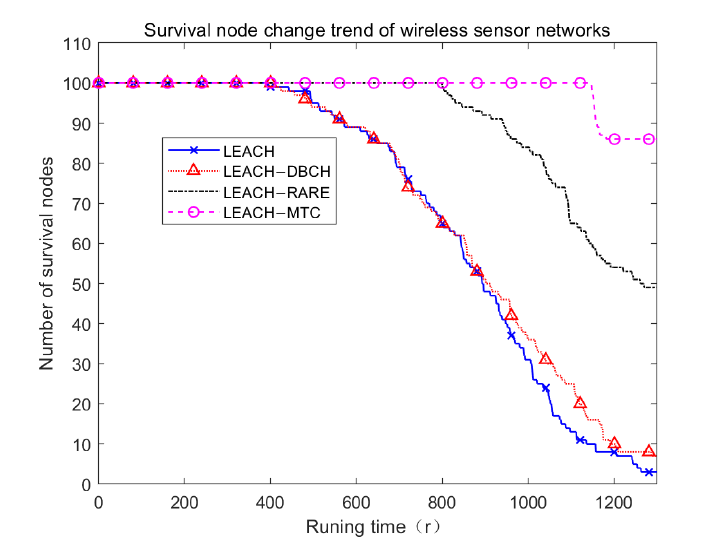
Figure 6. The number of network surviving